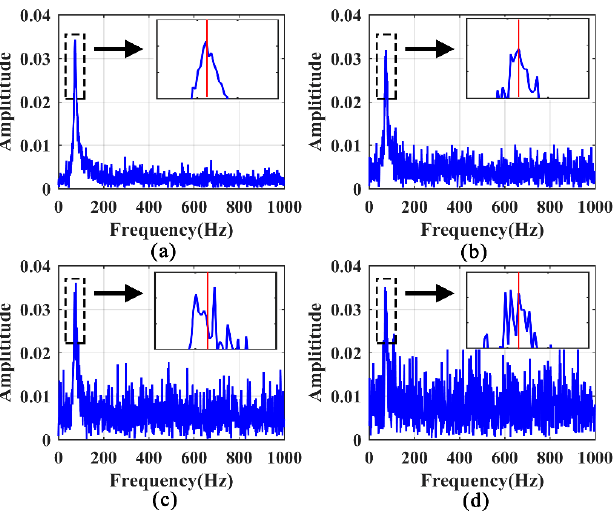
Figure 16. Identification of LPF in frequency spectrums of noisy signals excited by HE: ( a ) σ = 0.05;